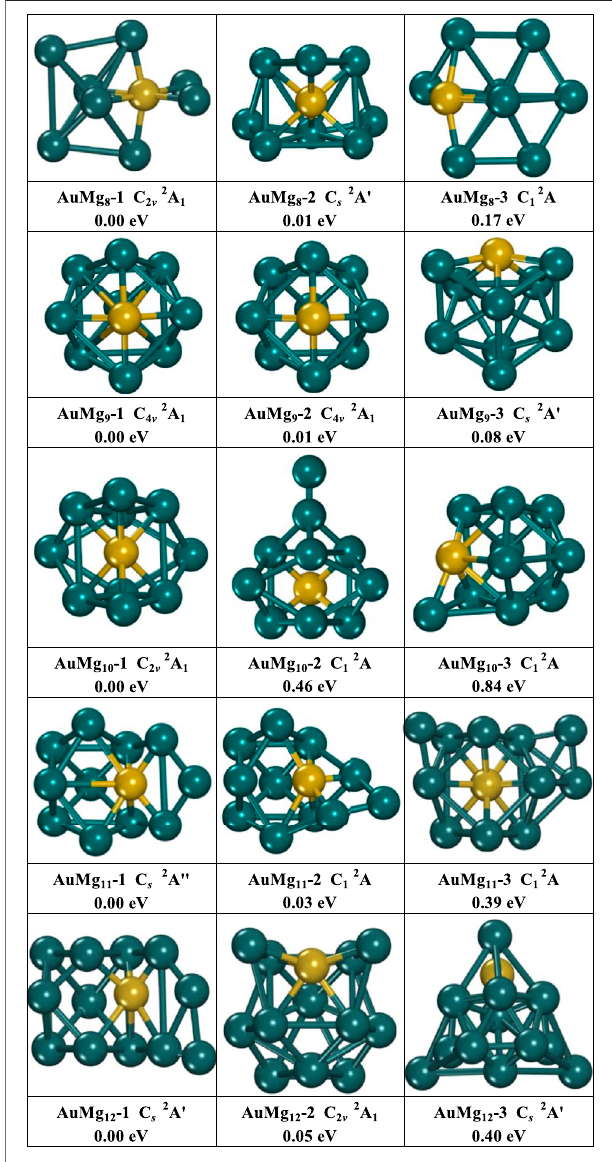
FIGURE 2 | The geometry of the three lowest energy isomers of AuMg n ( n =8 – 12)nanoclusters,energydifferenceineVfromthelowestenergyisomer at the same